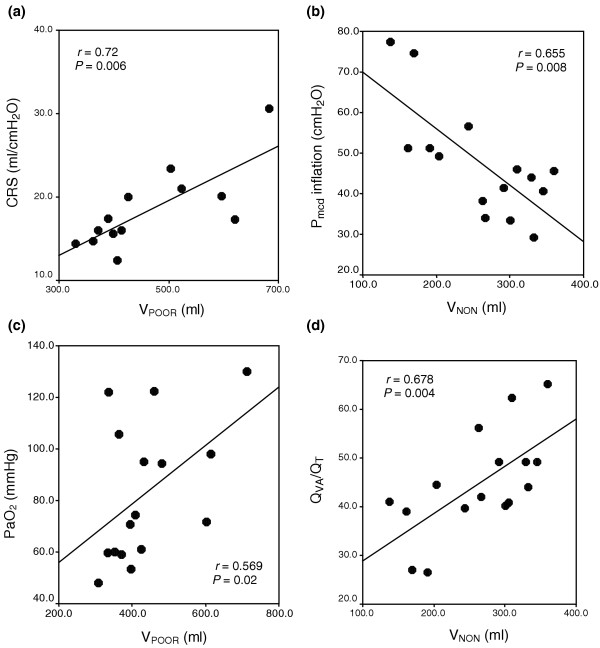
Correlation of expiratory multi-slice CT lung volumes with respiratory mechanics and gas exchange parameters. CRS, static compliance of respiratory system; PaO2, arterial partial oxygen pressure; Pmcd, pressure of maximum compliance decrease on inflation curve; QVA/QT, venous admixture; VNON, nonaerated lung volume; VPOOR, poorly aerated lung volume.